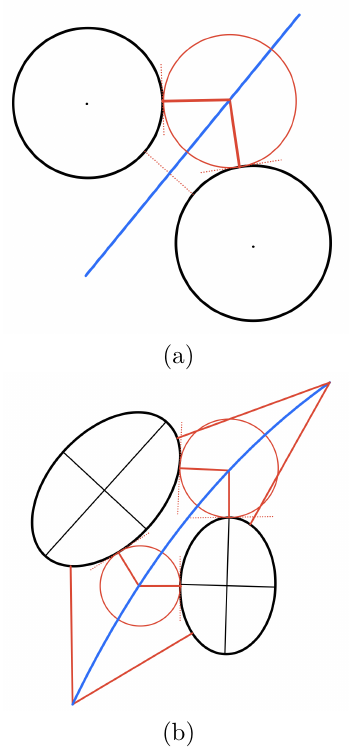
Figure 5. Generating boundary between